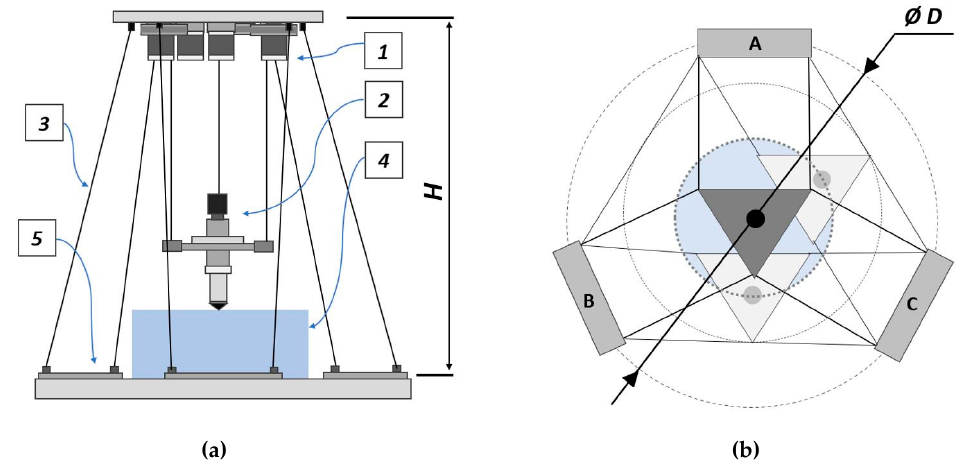
Figure 1. Scheme of the hybrid printer. ( a ) side view, ( b ) top view. 1—ceiling unit, 2—effector (FPF/FGF extruder), 3—wires, 4—cylindrical working volume, 5—printing bed, A, B, and C—anchors; H = 190 cm (height of the printer), Ø D = 140 cm (diameter of the lower part of the printer).